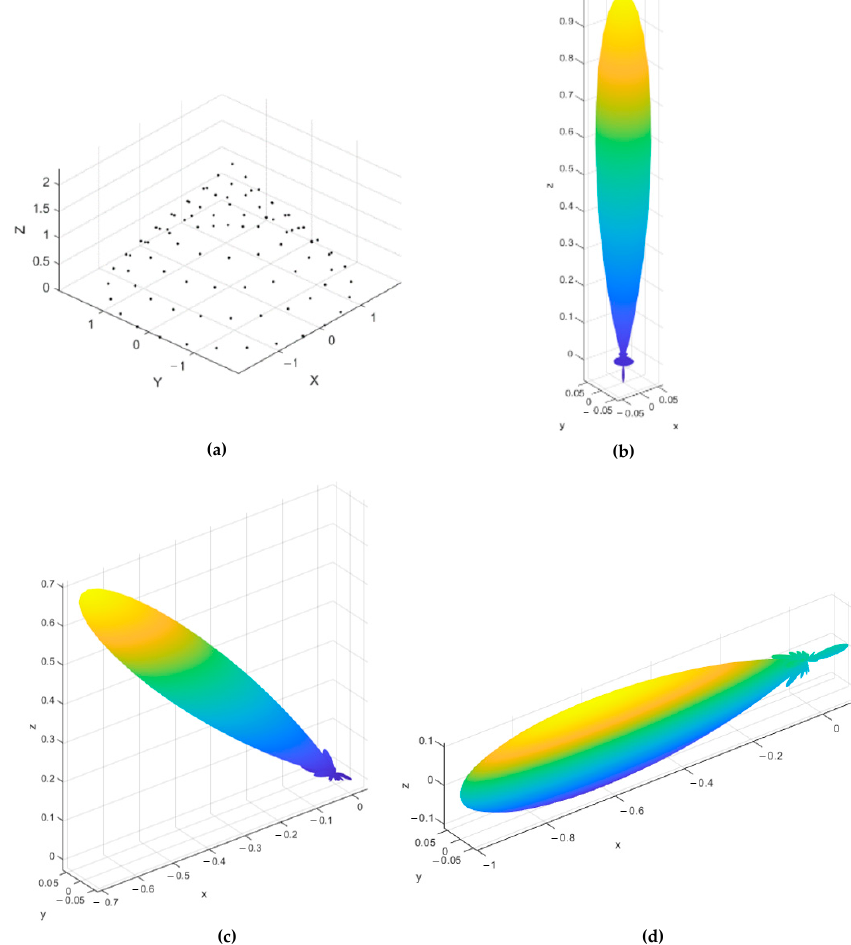
Figure 2. Uniform conical array structure and beam characteristics at three mainlobe directions: ( a ) array structure, ( b ) normalized 3D power pattern for a mainlobe at (0°, 180 °), ( c ) normalized 3D power pattern for a mainlobe at (45°, 180 °) , and ( d ) normalized 3D power pattern for a mainlobe at (90°, 180 °).